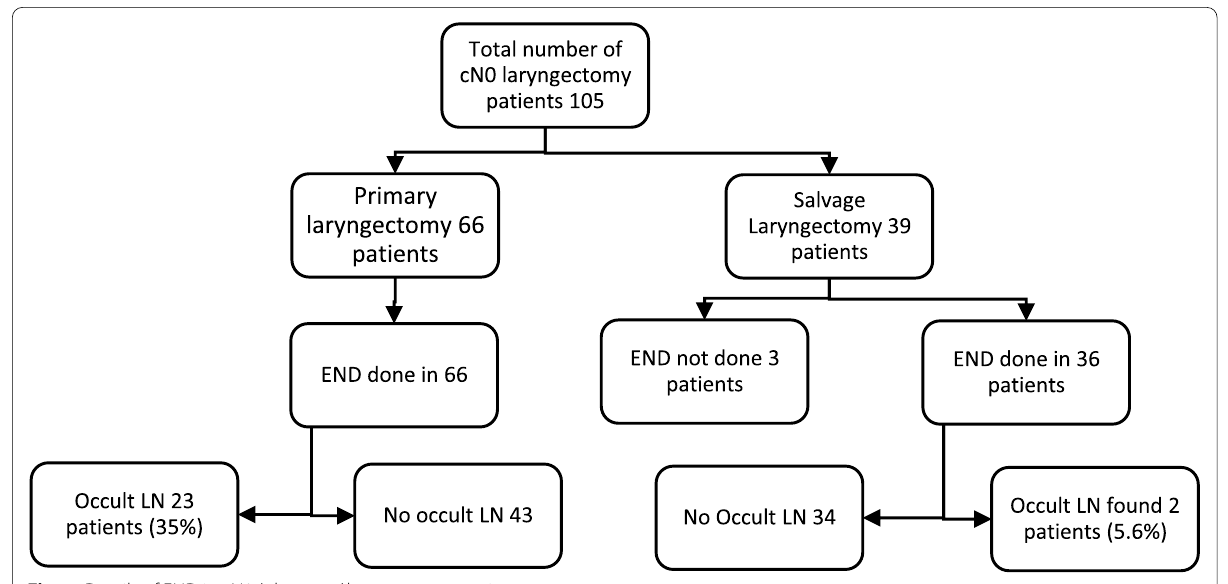
Fig. 1 Details of END in cN0 (pharyngo)laryngectomy